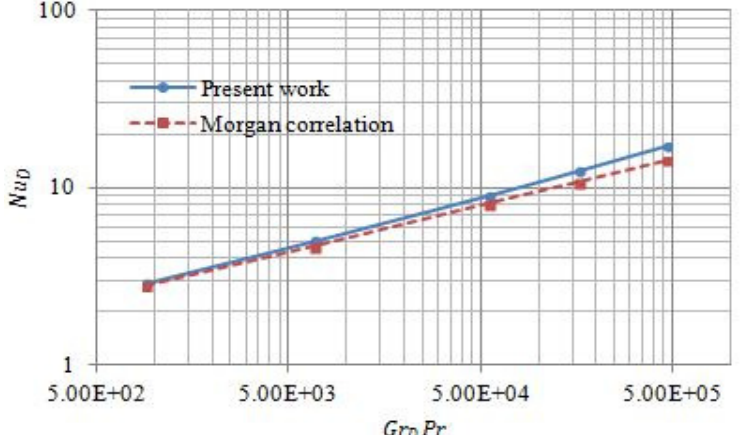
Fig. 12. Comparison the present experimental data for a heated smooth tube with Morgan [1] correlation